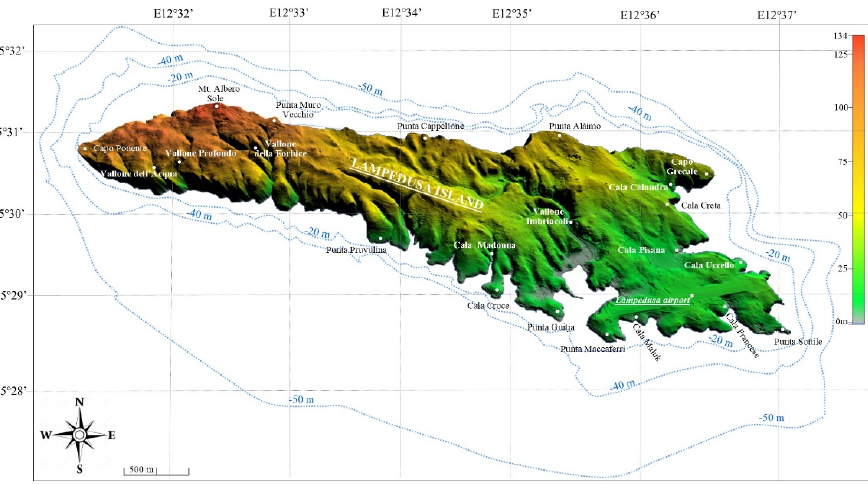
Figure 6. Geomorphological setting of Lampedusa island based on a 2 m × 2 m Digital Terrain Model (https://www.sitr.regione.sicilia.it/geoportale/it/metadata/details/502, accessed on 3 October 2022). The quantitative study of the landforms through analysis of the available digital ter ‐ rain model (2 × 2 m cell ‐ size resolution) into a GIS workstation allowed to derive thematic